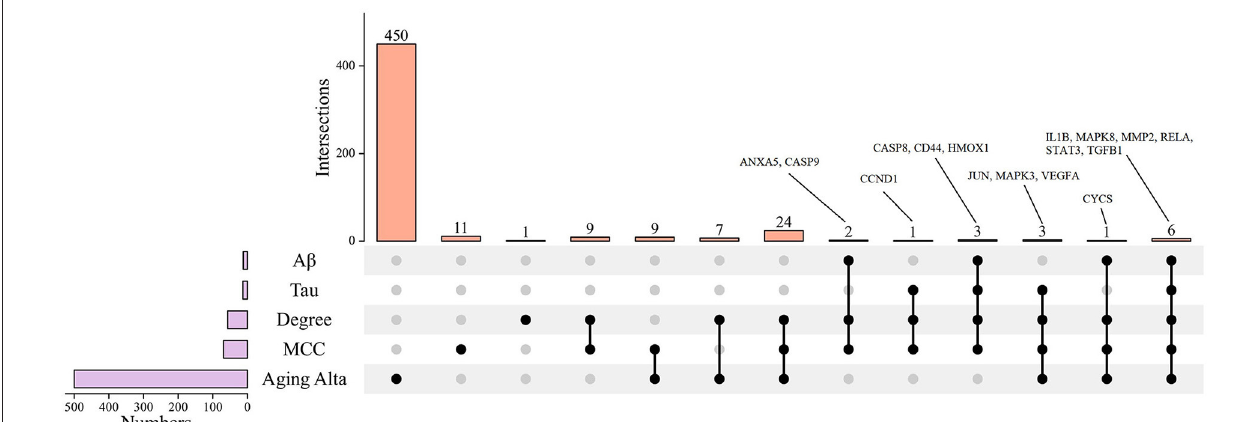
FIGURE 9 | Core target enrichment